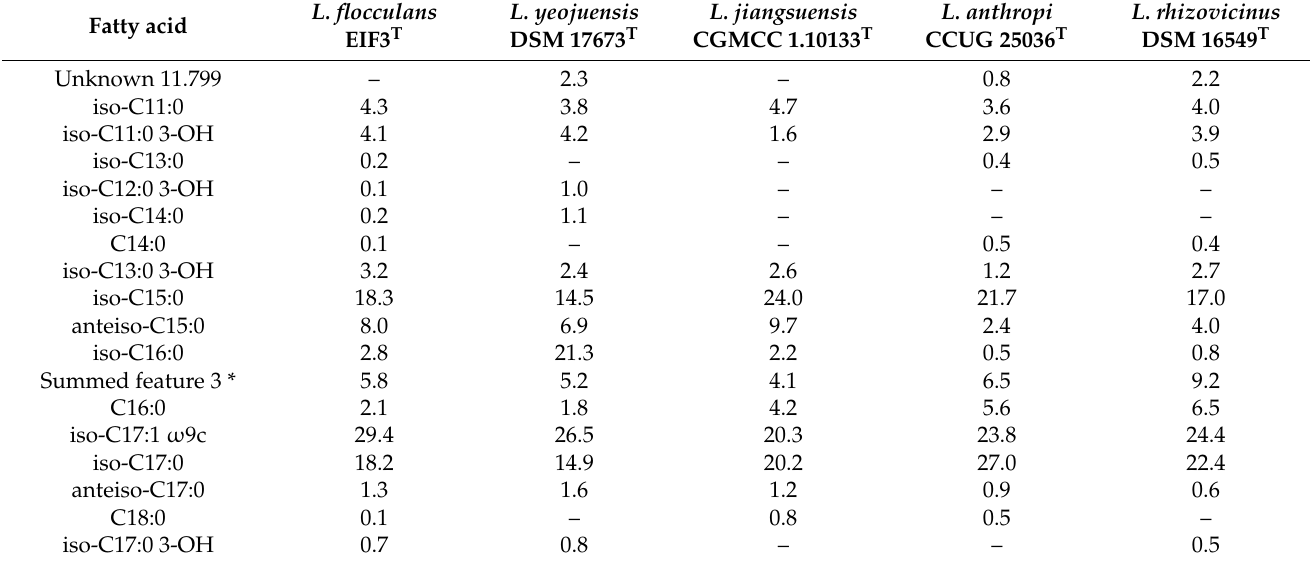
Table 2. Composition of cellular fatty acids (%) in strain EIF3 T and phylogenetically related species L.